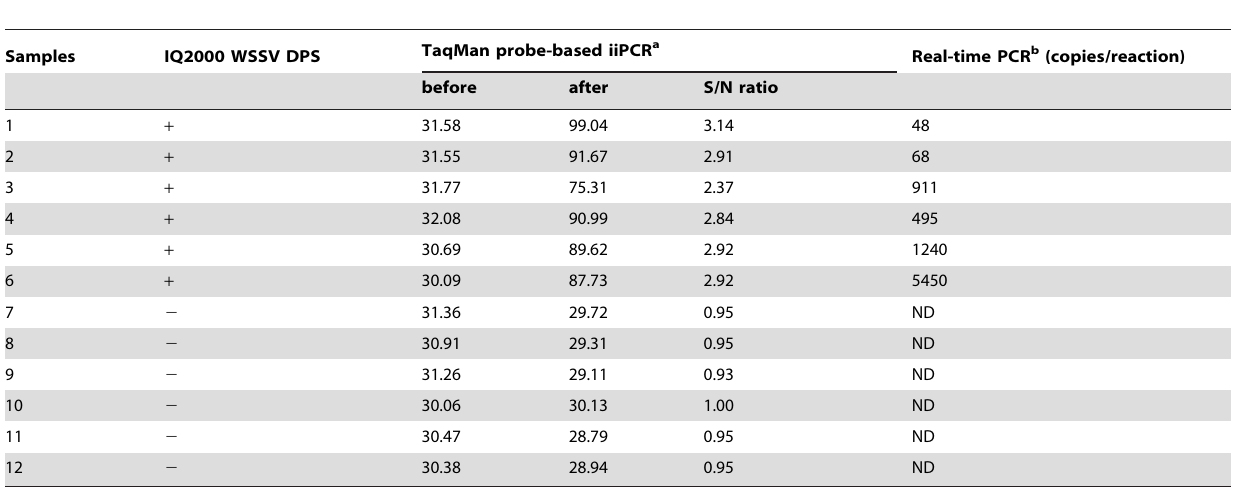
Table 1. Detection of WSSV DNA in shrimp samples by IQ 2000 WSSV D&P System, WSSV TaqMan probe-based iiPCR, and real- time PCR assays.